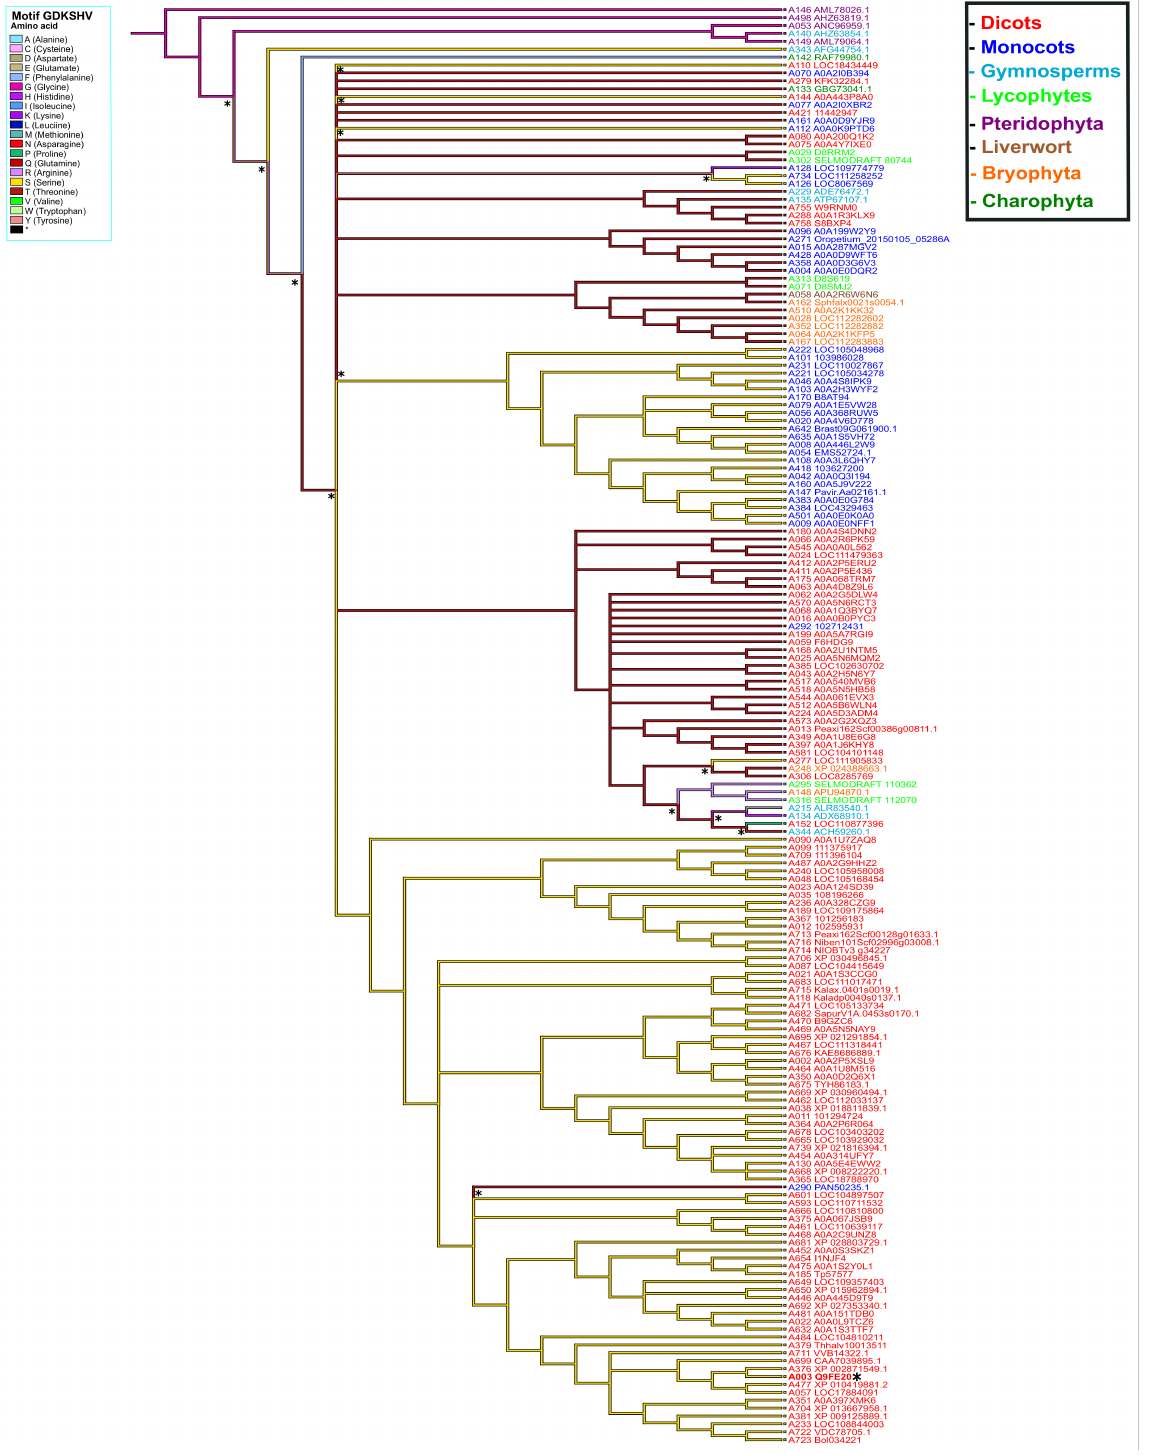
Figure 8. Ancestral state reconstruction in PBS1 orthologs based on the GDKSHV motif. Ancestor reconstruction was carried out with the maximum parsimony algorithm using as ancestral character the PBS1 amino acid sequence. Reconstruction was carried out on amino acid 248 of PBS1. The colors in the branches indicate the evolutionary divergence of the ancestral amino acid. The color in the names indicates terrestrial plants species. Transitions and reversion are indicated with asterisks (*) above nodes. This figure shows the ancestral state of serine (S). Position of Arabidopsis in tree is indicated with asterisk (*) and bold red to observe the ancestry of other amino acids; see Supplementary Figures S2 and